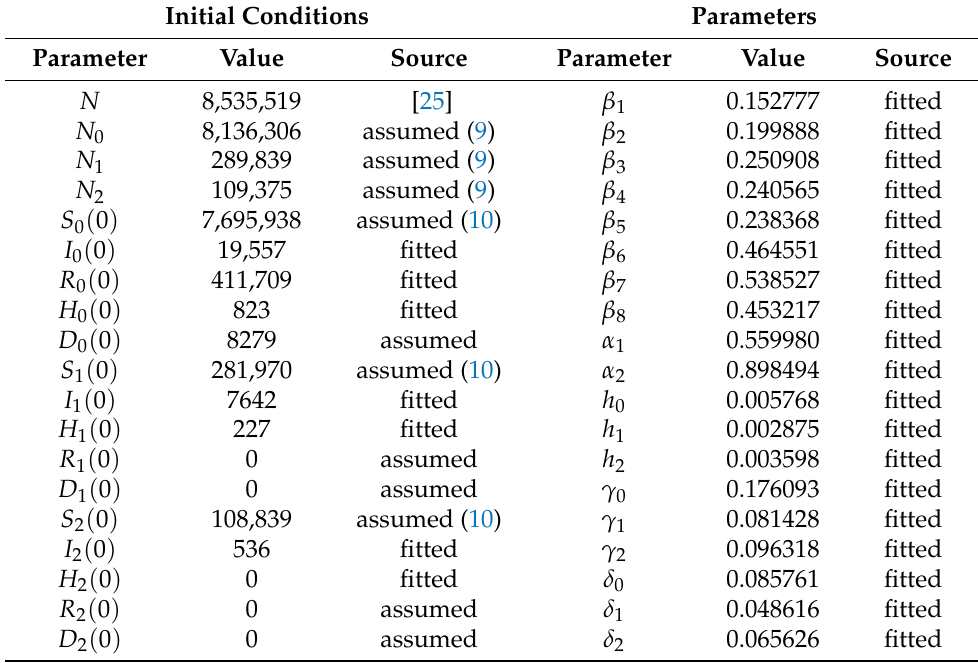
Table 2. Best fitting initial conditions (left) and parameters (right) for the two-stage vaccination model (1) and corresponding system of differential Equation (2) with piece-wise constant transmission function β ( t ) (3), and vaccination uptake curve V i ( t ) (4) with parameters from Figure 1.